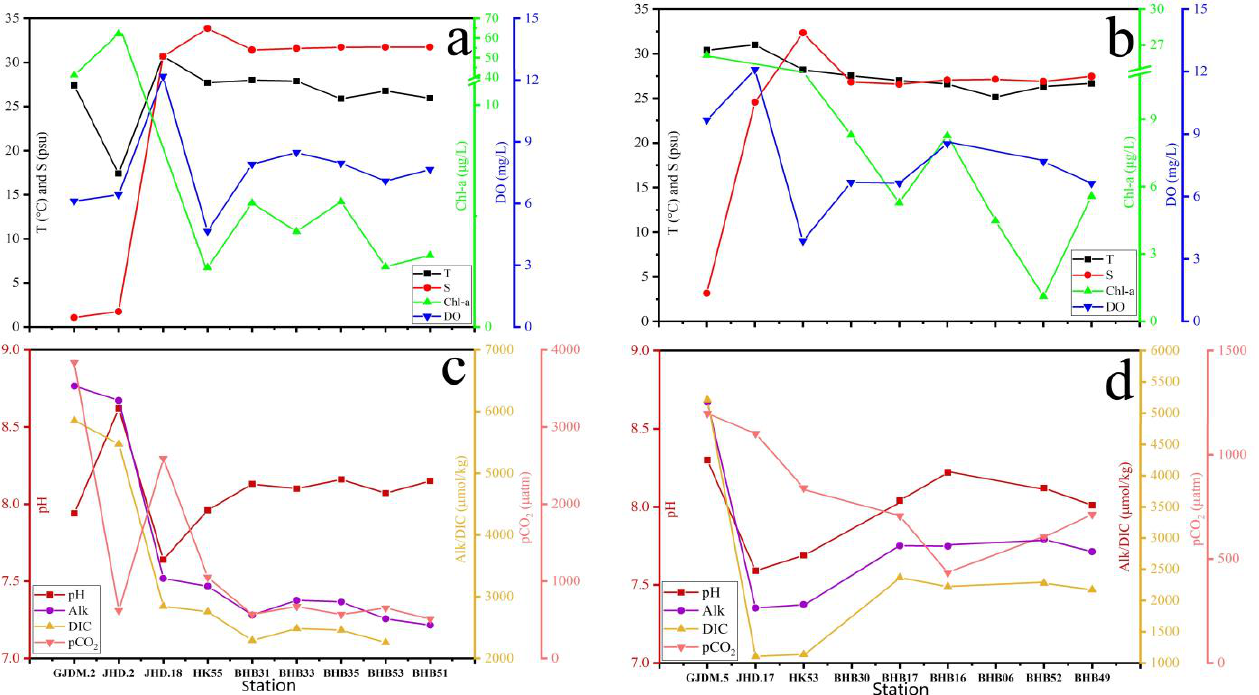
Figure 10. Related parameters in transect A ( a ) and the distribution of the surface carbonate species ( c ) in Bohai Bay under the input of the Tuhai River. Related parameters in transect B ( b ) and the distribution of the surface carbonate species ( d ) in Bohai Bay under the input of the Majia River in summer 2020.